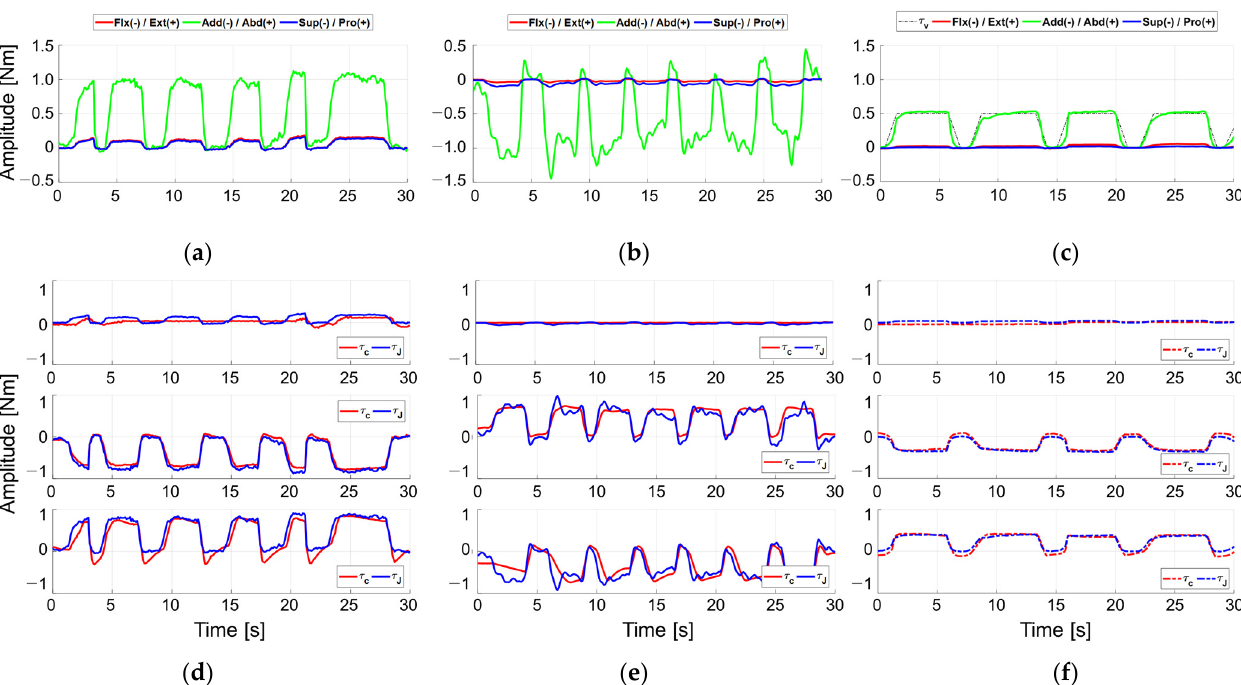
Figure 7. Measured torques during force control experiments for AA motion. ( a – c ) show the measured torque τ u and ( d – f ) show the torques of three actuators from measurement (red) and those estimated from active currents in the actuators (blue). ( a , b ) and ( d , e ) are the control results according to the user’s intention without virtual torque, and ( c , f ) are the control results by the applied virtual torque while the user maintains the robot in its initial posture.